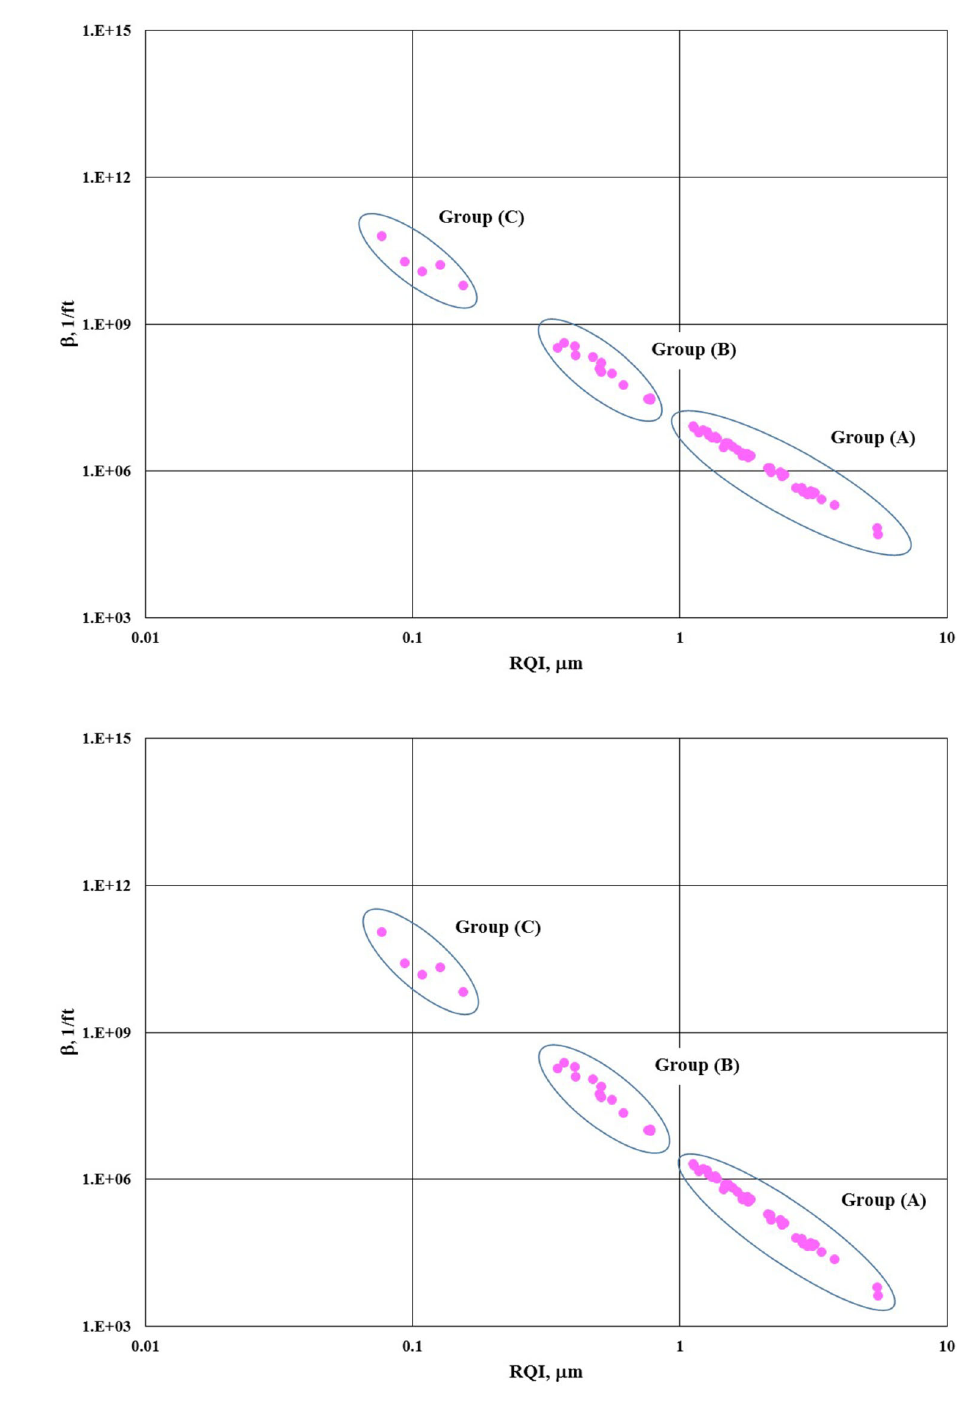
Fig. 6 Turbulence factor versus